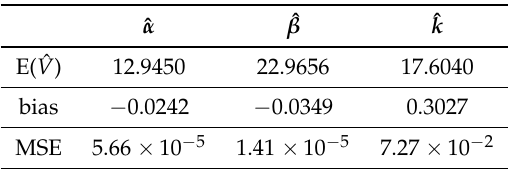
Table 13. Gradient method.